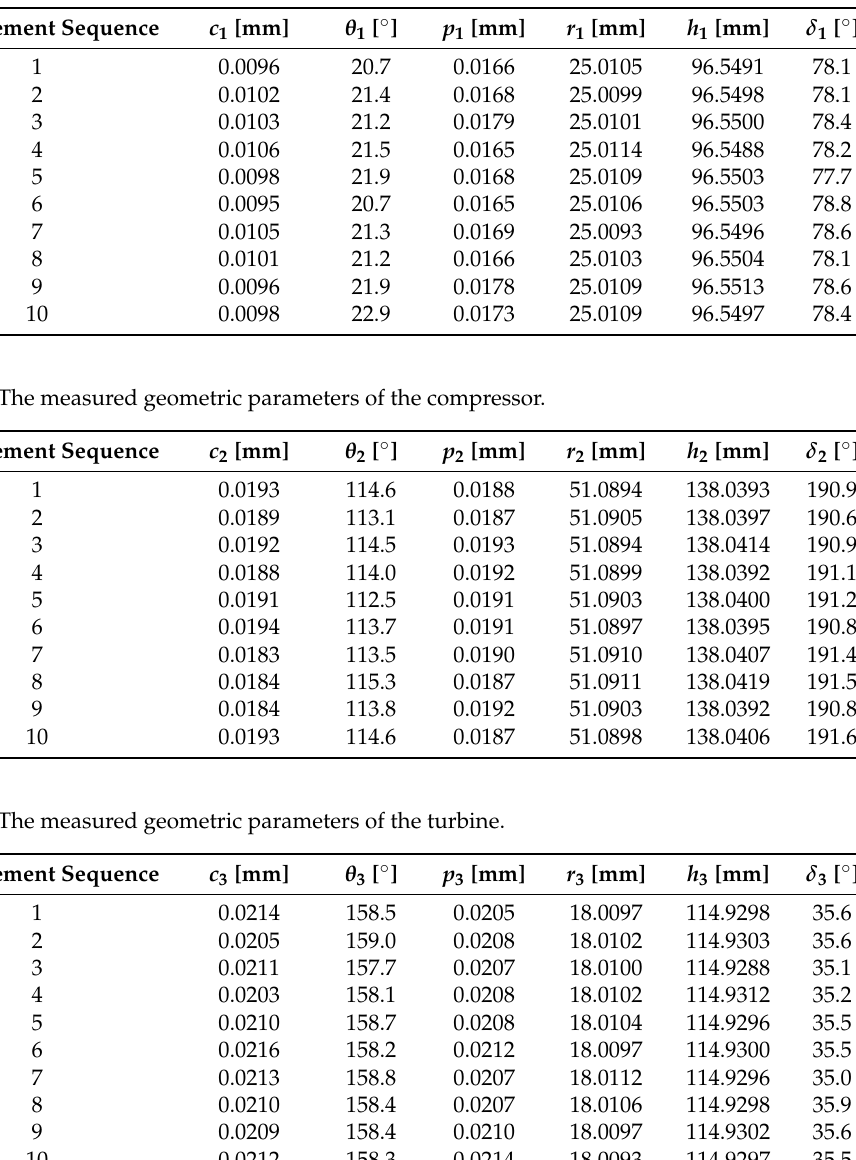
Table A1. The measured geometric parameters of the front axle.